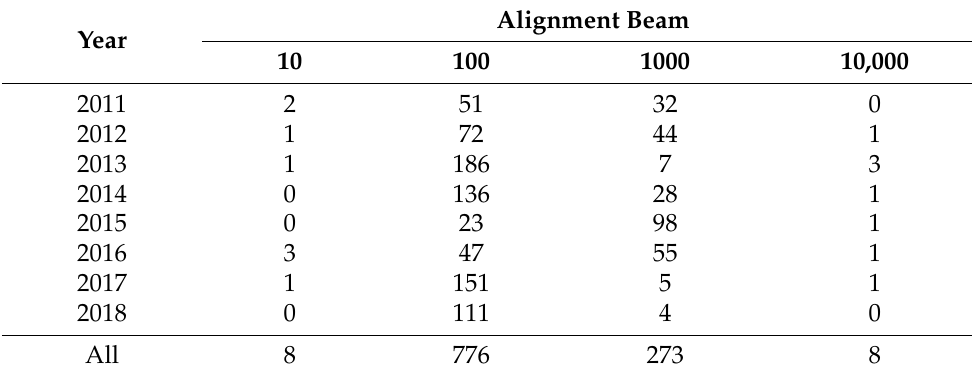
Table 2. Number of aligned audio and transcription files via forced alignment with different beam sizes.